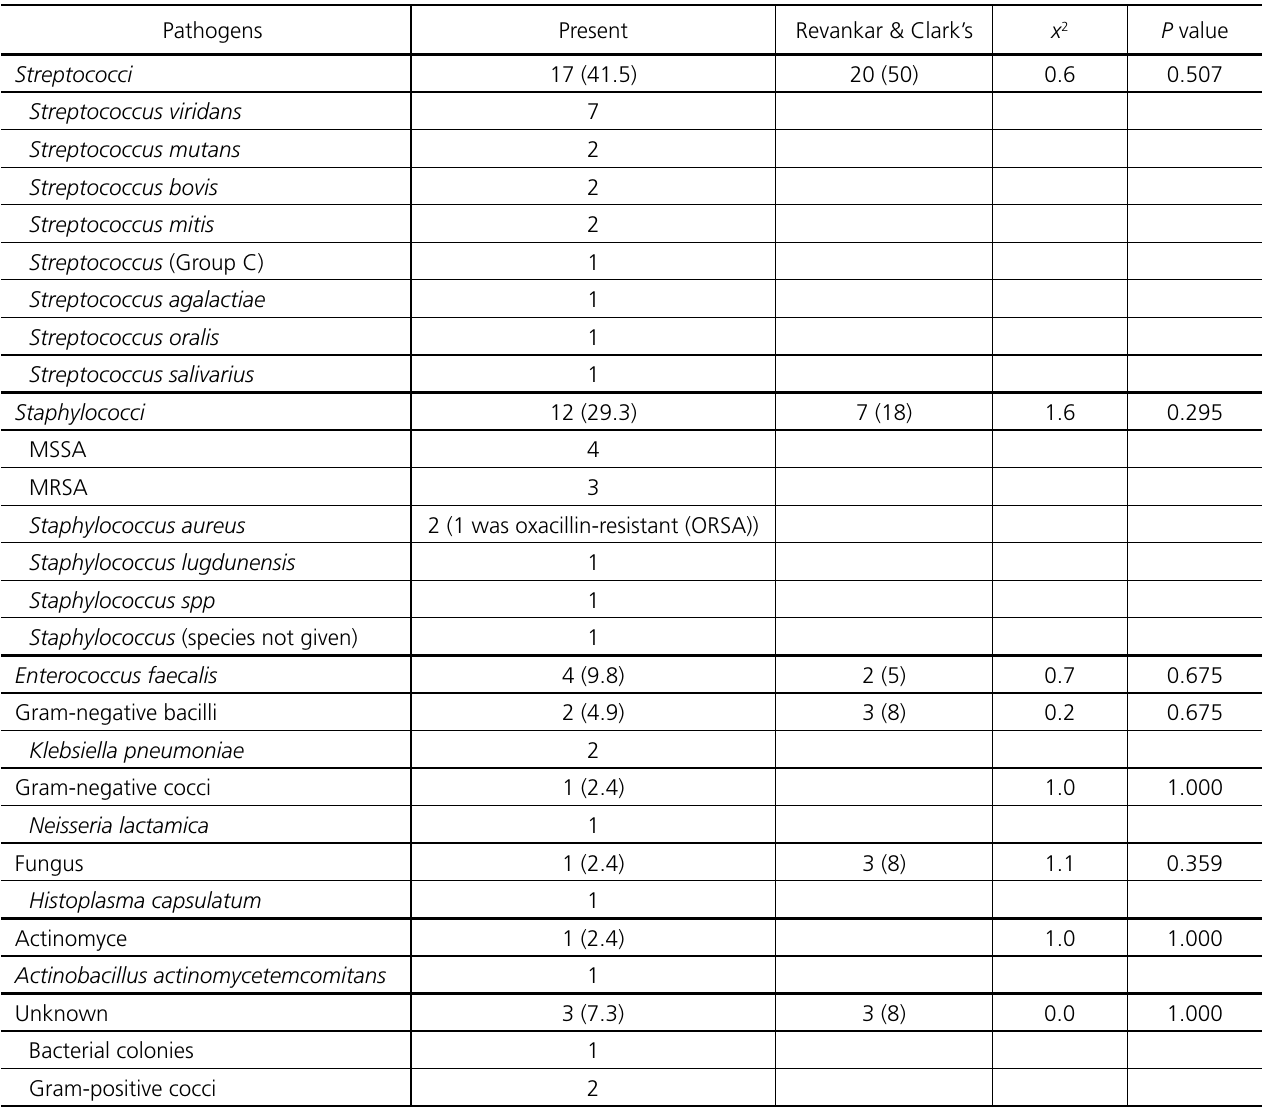
Table 4. Pathogens of infective cardiac myxoma.